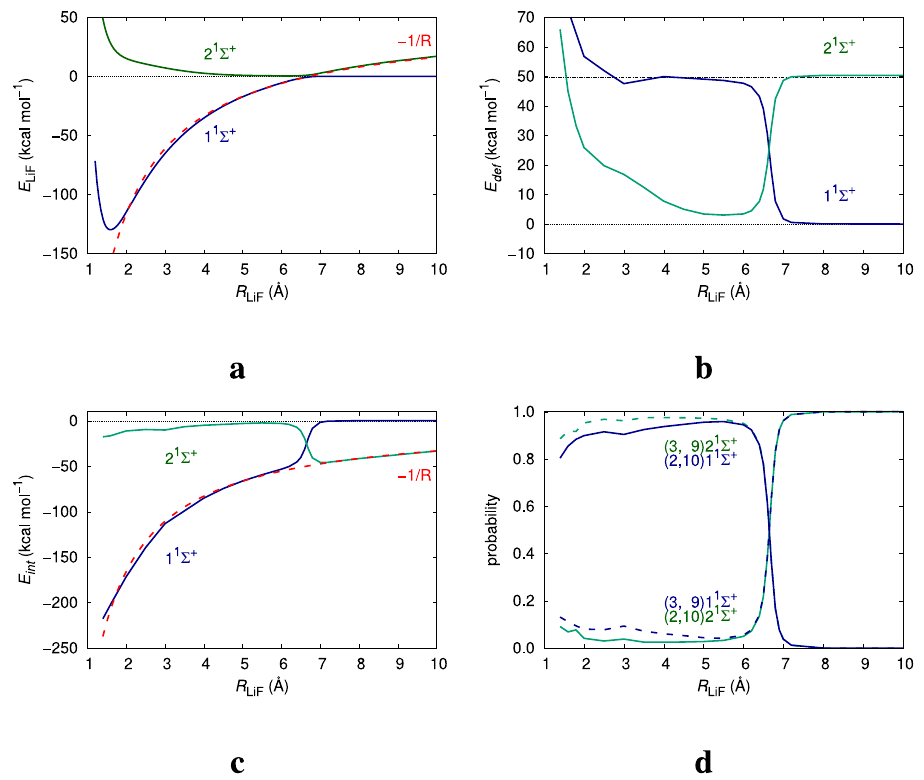
Fig. 4 Spatial partitioning in LiF. d-aug-cc-pVDZ MRCI-SD data in both the S0 (1 1 Σ + , dark-blue) and S1 (2 1 Σ + , dark-green) states along the dissociation curve. a Total energy, showing the avoided crossing (the ≈ 2 kcal mol − 1 gap is barely visible at the scale of the plot), with the Coulombic − 1/ R tail in red. þ E F ). The energy reference is set to the neutral reference, while the ionization cost of LiF is 49.5 kcal mol − 1 . c Total E LiF b Total self-energy ( E Li self self together with the Coulombic − 1/ R contribution, in red. d Probabilities p ( n Li , n F ) of the main electron distributions. The neutral (3,9) and ionic (2,10) partitions are plotted in dashed and full lines,